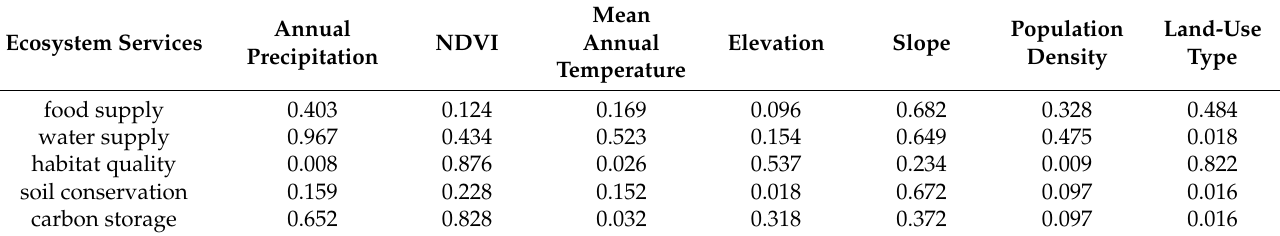
Table 2. Detection results of ecosystem service factors of the western Sichuan